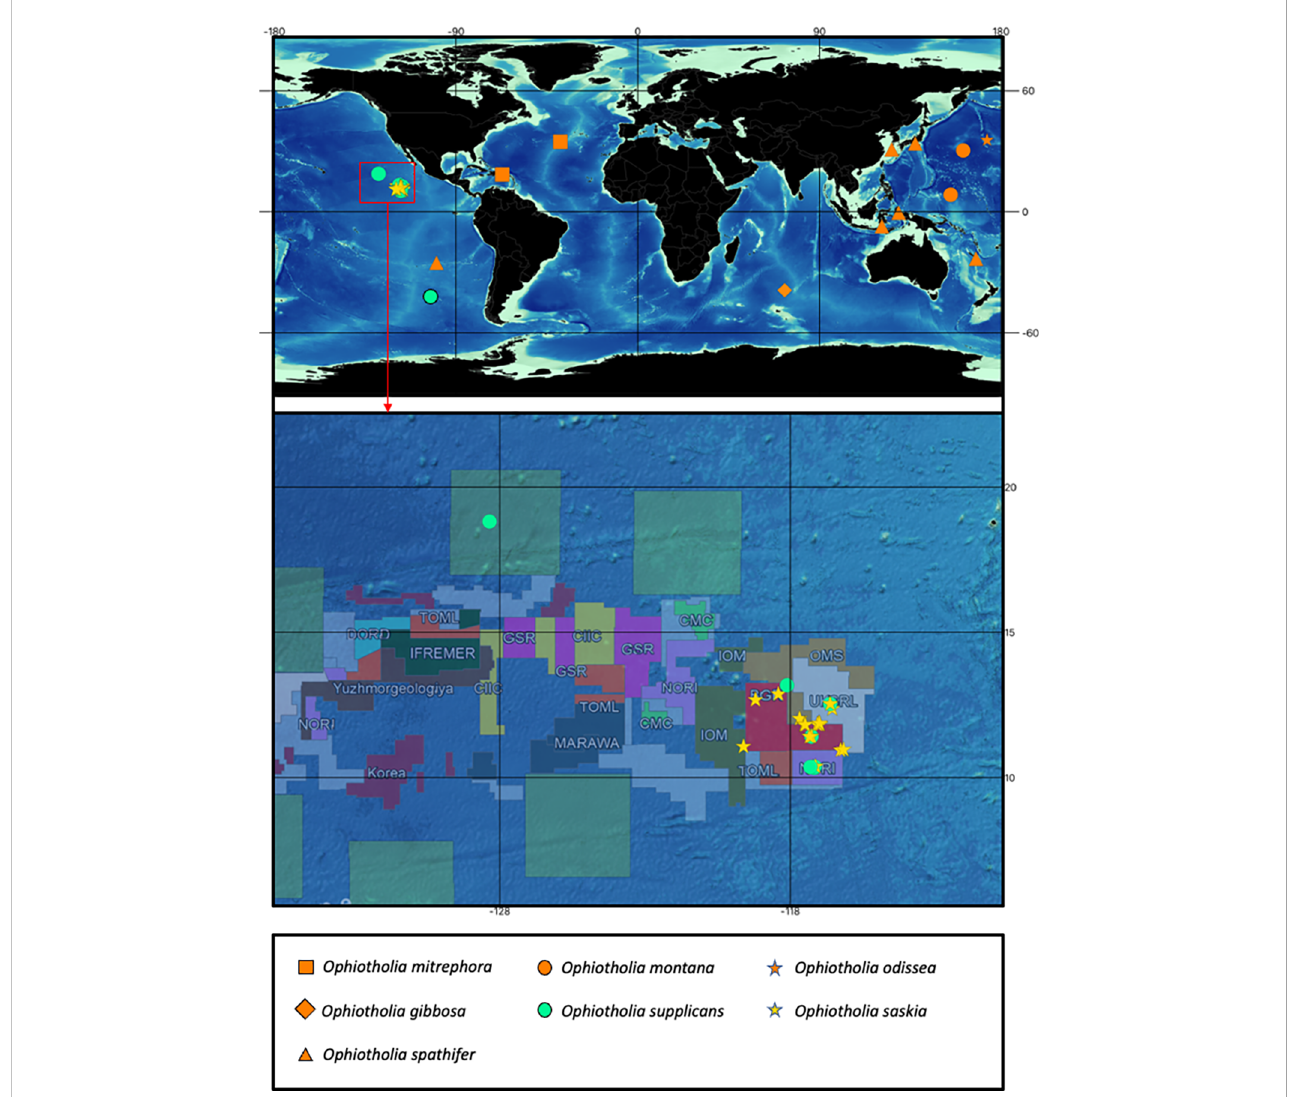
FIGURE 1 Map with the recorded distributions from all recent species of the genus Ophiotholia. The colour of the upper map indicates: orange, distributions recorded for species with just morphological data; yellow and turquoise, distributions recorded from species with morphological and molecular data. A unique combination of colour and symbol is assigned to each species. Detailed map of the Clarion Clipperton Zone showing the distribution of the cooccurring species Ophiotholia saskia sp. nov. and Ophiotholia supplicans . The distribution map of the Ophiotholia species was created using QGIS (version 3.16, http://www.qgis.org), considering the data of the International Seabed Authority